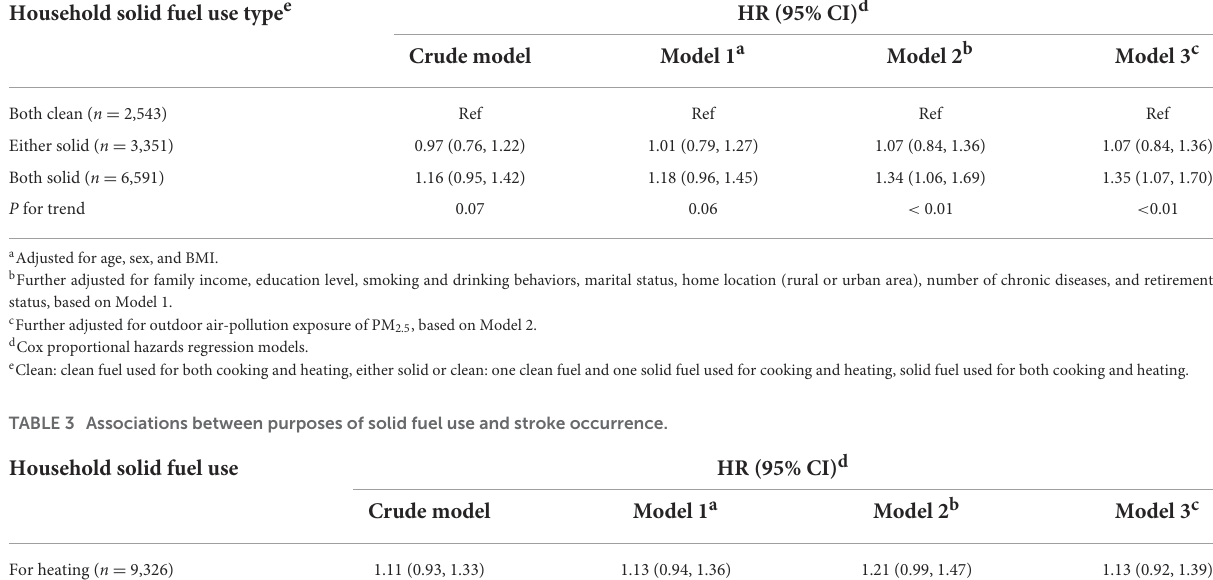
TABLE 2 Associations between household solid fuel use and stroke occurrence.